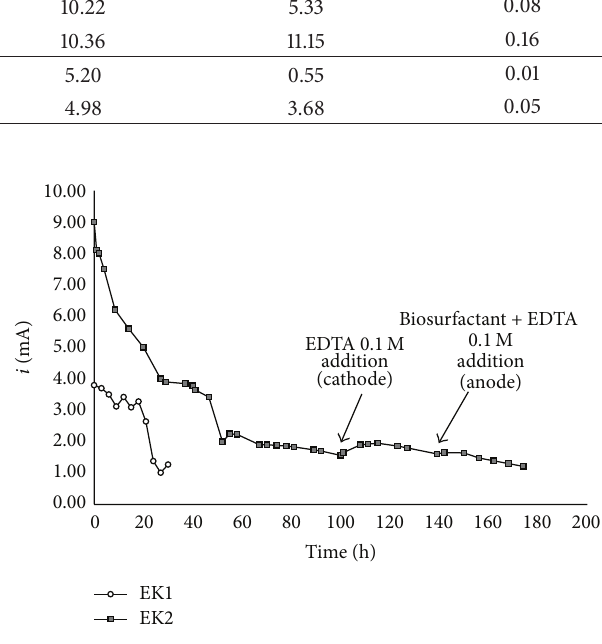
Figure 4: Electric current intensity ( 𝑖 ) as a function of treatment time (EK1, EK2).